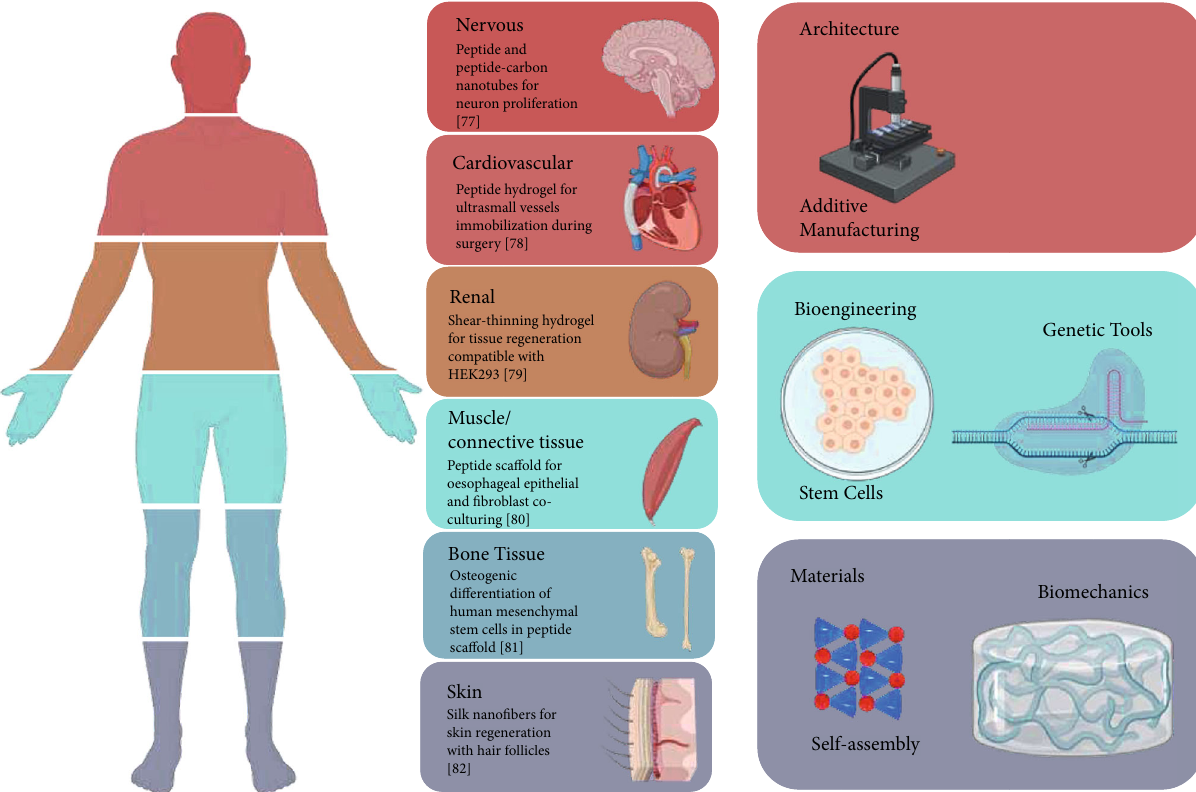
Figure 2: TE is built on the following important pillars comprised of the development of organ and tissue architecture, bioengineering techniques, and material science. SBPs are involved in all these three pillars of TE with the aim to develop tissue-speci fi c constructs for a variety of complex human organ systems; nowadays, SBPs have proven resourceful for the proliferation of neurons [60], endothelial cells [61], kidney cells [62], fi broblasts [63], osteocytes from mesenchymal stem cells [64], and complex skin regeneration [65]. SBPs can be used cooperatively with other technologies to create versatile and smart sca ff olds for TE. For instance, in order to obtain complex architectures, SBPs can be coupled with additive manufacturing techniques [66]. SBPs can also be coupled with bioengineering tools such as the use of stem cells [67] to create complex tissue-like cultures or the use of genetic tools to create active therapeutic sca ff olds [68]. Finally, these materials can be designed to have triggered assembly mechanisms [26], as well as to control cell mechanics by their structural composition